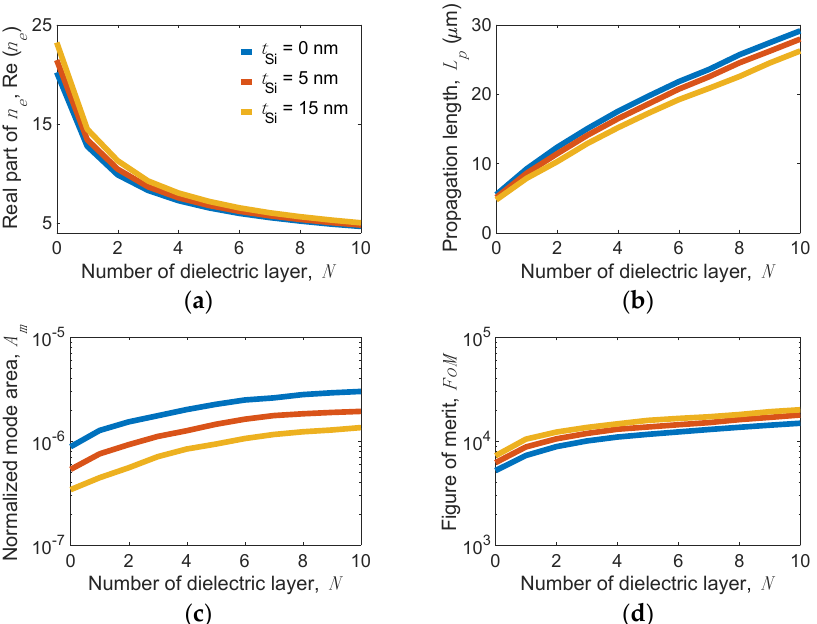
Figure 3. ( a ) Real part of effective index n e , Re( n e ), ( b ) normalized mode area, A m , ( c ) propagation length, L p , and ( d ) figure of merit, FoM versus the number of dielectric layer, N for the present structure operating at f = 20 THz for different t Si values at parameters of w g = 200 nm, t d = 5 nm, w r = 10 nm, h r = 30 nm, and E F = 0.6 eV.